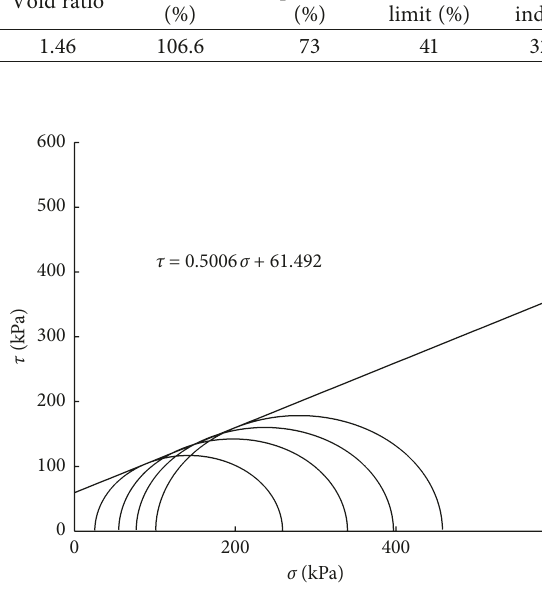
Figure 2: Strength envelope of compacted